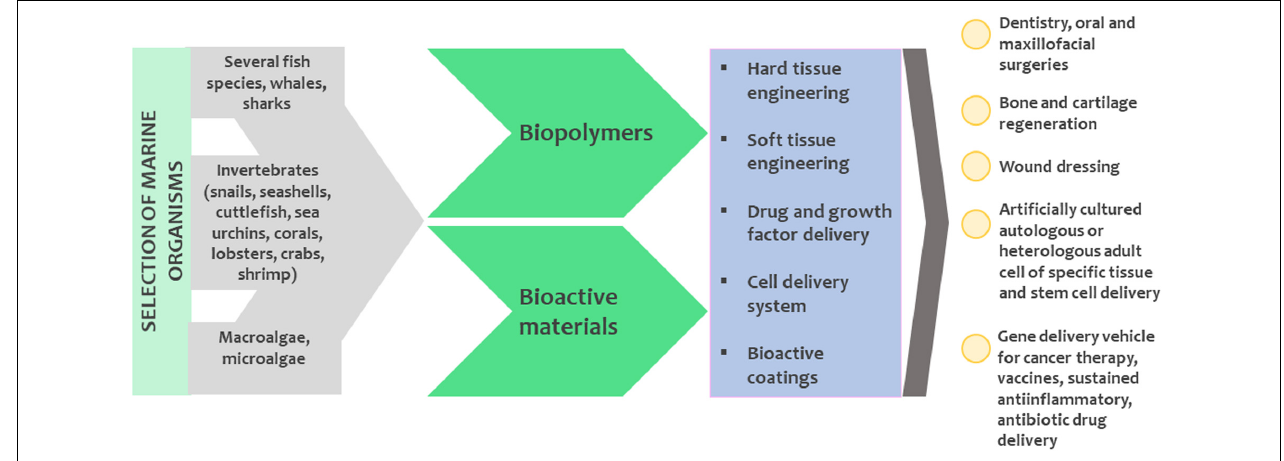
FIGURE 6 | The potential for using marine organisms to produce biomaterials for medical